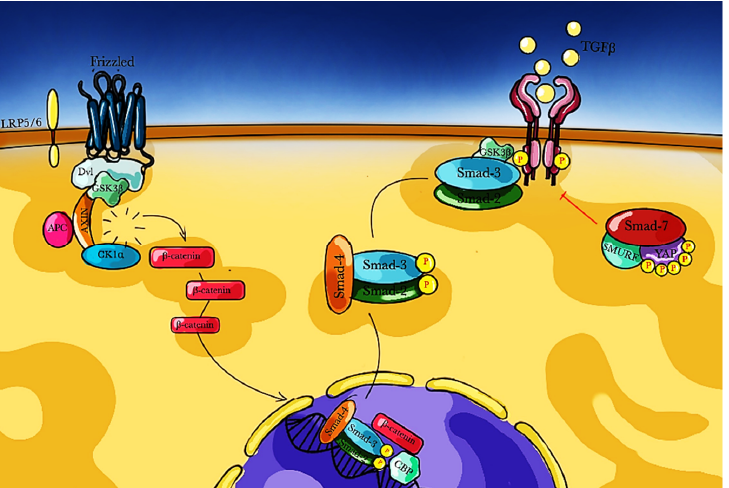
Figure 2. WNT/ β catenin pathway and its relation to gene transcription driving fibrogenesis. APC: Adenomatous poly- posis coli protein; CK1α: Casein kinase 1α; DVL: Dishevelled protein; GSK3 β: Glycogen synthase kinase 3 β; LRP: Lipo- protein receptor-related proteins; P: phosphorus; SMAD: small mother against decapentaplegic protein; TGFβ: tumor growth factor β; YAP: yes-associated protein.